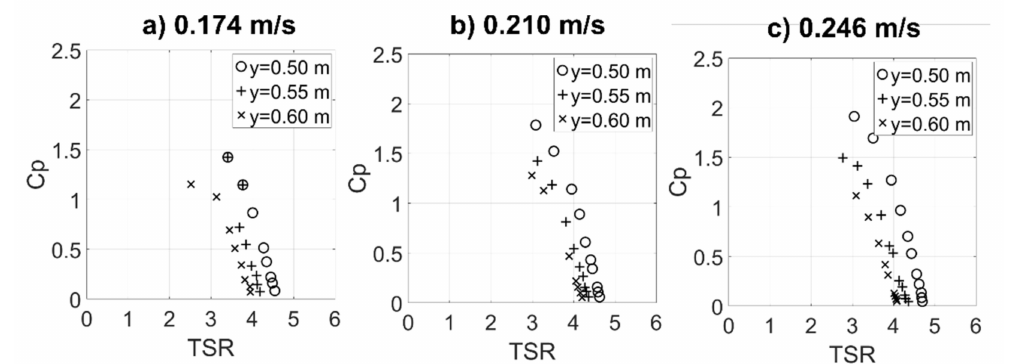
Figure 11. Cp vs. TSR curves for the three water velocities tested using the accelerator device.